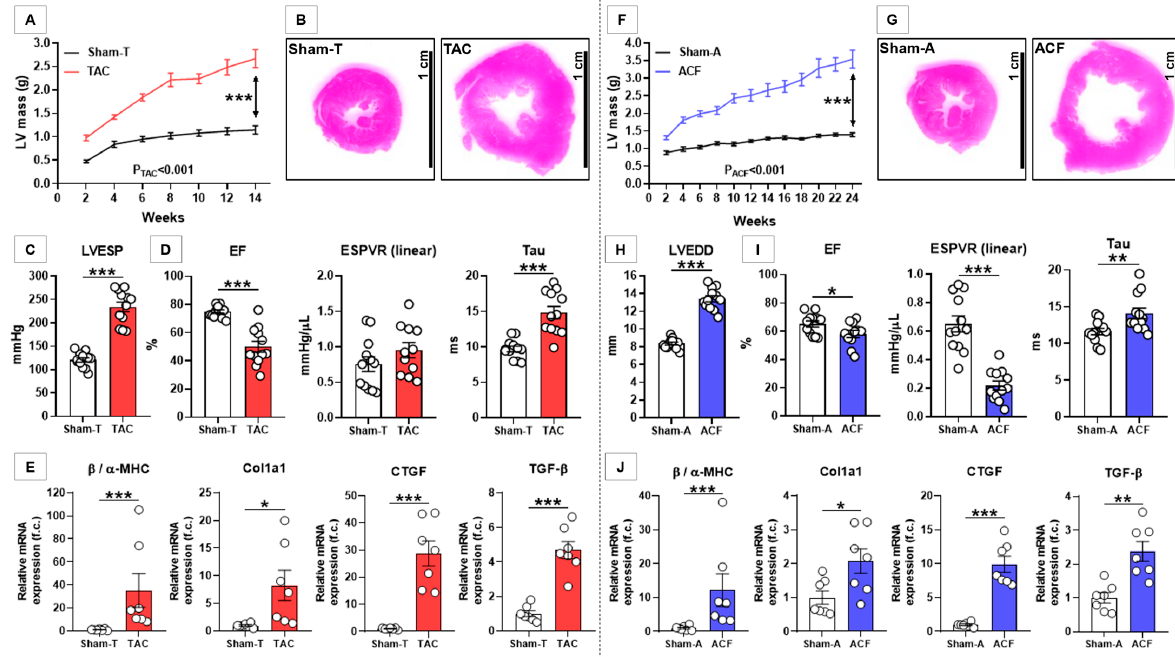
Figure 1. Characterization of pressure and volume overload-induced heart failure. ( A ) Temporal changes in left ventricular (LV) mass according to the Sham-T and pressure-overloaded (TAC) groups. ( B ) Representative histological section at the mid-papillary level of a control (Sham-T) and a TAC heart. ( C ) LV end-systolic pressure (LVESP) in Sham-T and TAC groups. ( D ) LV ejection fraction (EF), end-systolic pressure-volume relationship (ESPVR) and time constant of LV pressure decay (Tau) in Sham-T and TAC groups. ( E ) LV myocardial mRNA expression of pathological hypertrophy markers β / α -myosin heavy chain ( β / α -MHC), collagen type I alpha 1 (Col1a1), connective tissue growth factor (CTGF), and transforming growth factor beta (TGF- β ). ( F ) Temporal changes in LV mass according to the Sham-A and volume-overloaded (ACF) groups. ( G ) Representative histological section at the mid-papillary level of a control (Sham-A) and an ACF heart. ( H ) LV end-diastolic diameter in Sham-A and ACF groups. ( I ) LV EF, ESPVR and Tau in Sham-A and ACF groups. ( J ) LV myocardial mRNA expression of pathological hypertrophy markers β / α -MHC, Col1a1, CTGF, and TGF- β . In the case of the gene expression data, values are normalized to the mean of the respective Sham group to depict fold changes. In the temporal analysis (LV mass), P TAC and P ACF represents hypothesis testing for the main effect of the type of HF. * p < 0.050, ** p < 0.010, *** p < 0.001. Table 1. Morphometric analysis of sham-operated and hemodynamically-overloaded hearts. Sham-T TAC p Value Sham-A ACF p Value Body weight, BW (g) 520 ± 17 439 ±